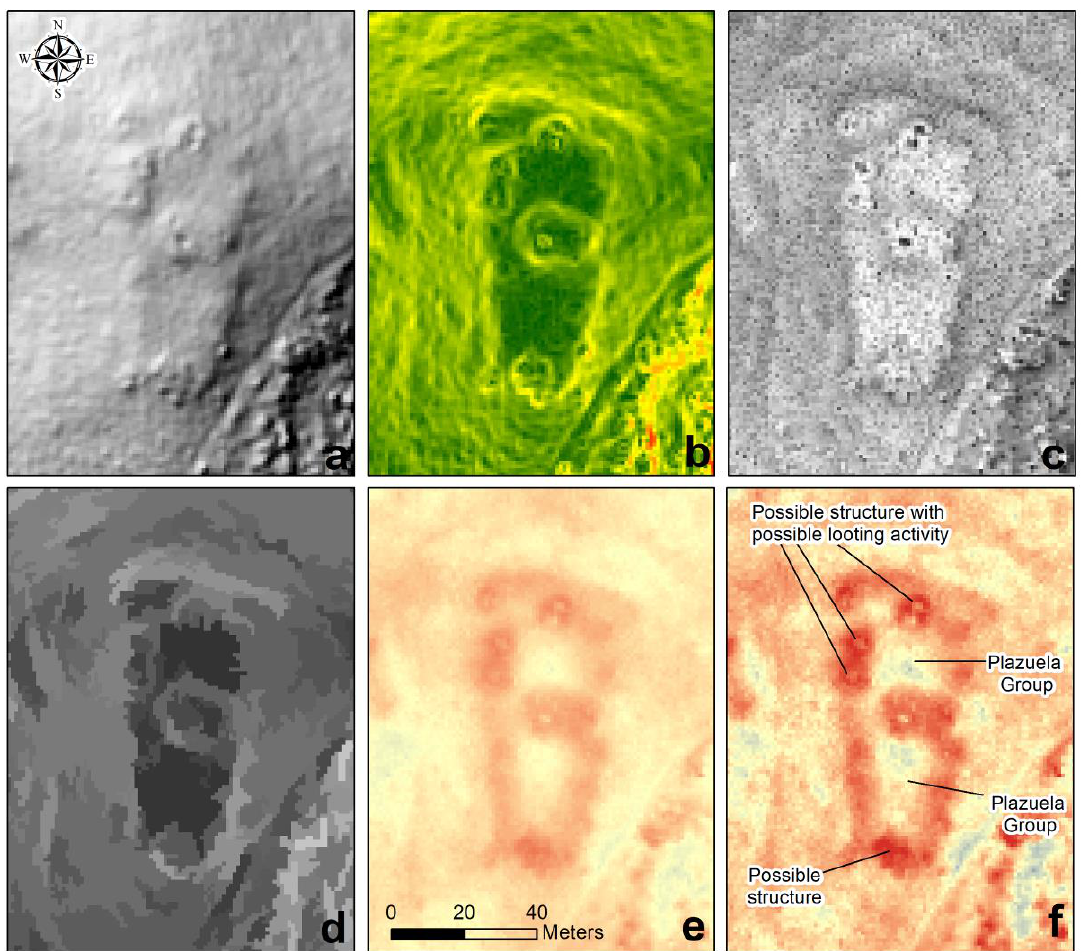
Figure 4. Relief visualization techniques used this this study, and the ability to visually detect archaeological features. This new identified plazuela is larger than most in the lidar dataset but nicely reflects the variations in visualizations for archaeological prospection (see Figure 5). ( a ) Hillshade: Modified (flattened) hilltops are difficult to detect, but some structures are visible. ( b ) Slope: The flattened hilltop is visible, as are some of the structures. ( c ) Sky-view factor (SVF): Flattened plazuelas and structures are difficult to detect, although potential looting activity stands out as dark spots on the image. ( d ) Object-based image analysis (OBIA): Flattened plazuelas are visually detectable, but structures are difficult to detect. ( e ) Topographic position index (TPI): Flattened plazuelas are visually detectable by the red circular/rectangular perimeter; structures are also visible. ( f ) Simple local relief model (SLRM): Plazuelas are easy to detect by the lighter plaza surrounded by a darker red perimeter suggestive of a flattened hilltop. Structures and possible looting activity are also easily visible. Plazuelas are most easily visually detectable on the SLRM and TPI images, compared to the OBIA and SVF images.